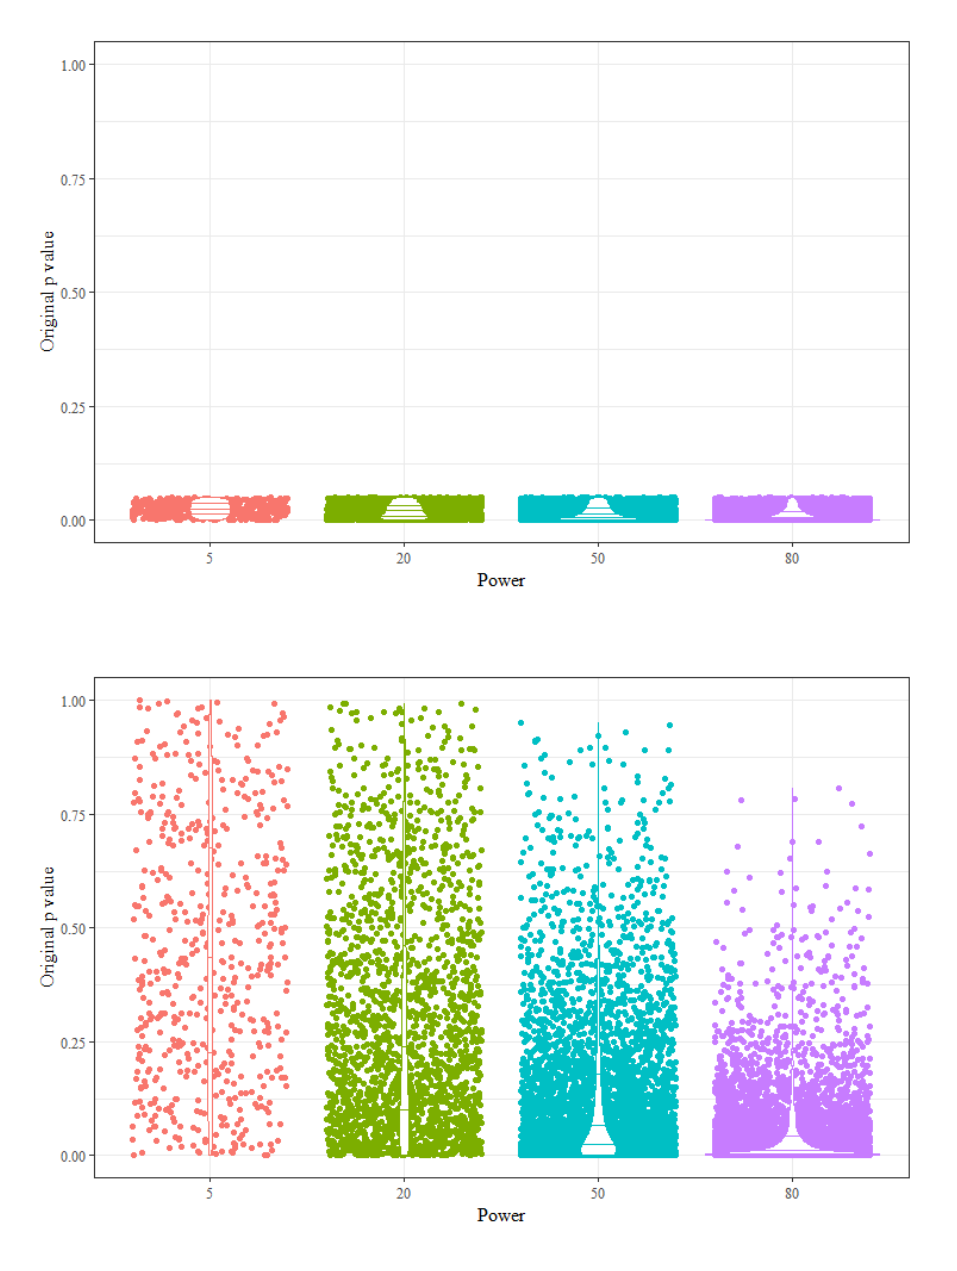
Figure A1 . The p -value distributions of the original significant studies, by power (top), and the p -value distribution of their exact replication studies by power in % (bottom). Violin plots are overlaid displaying the range and quantiles 25, 50 and